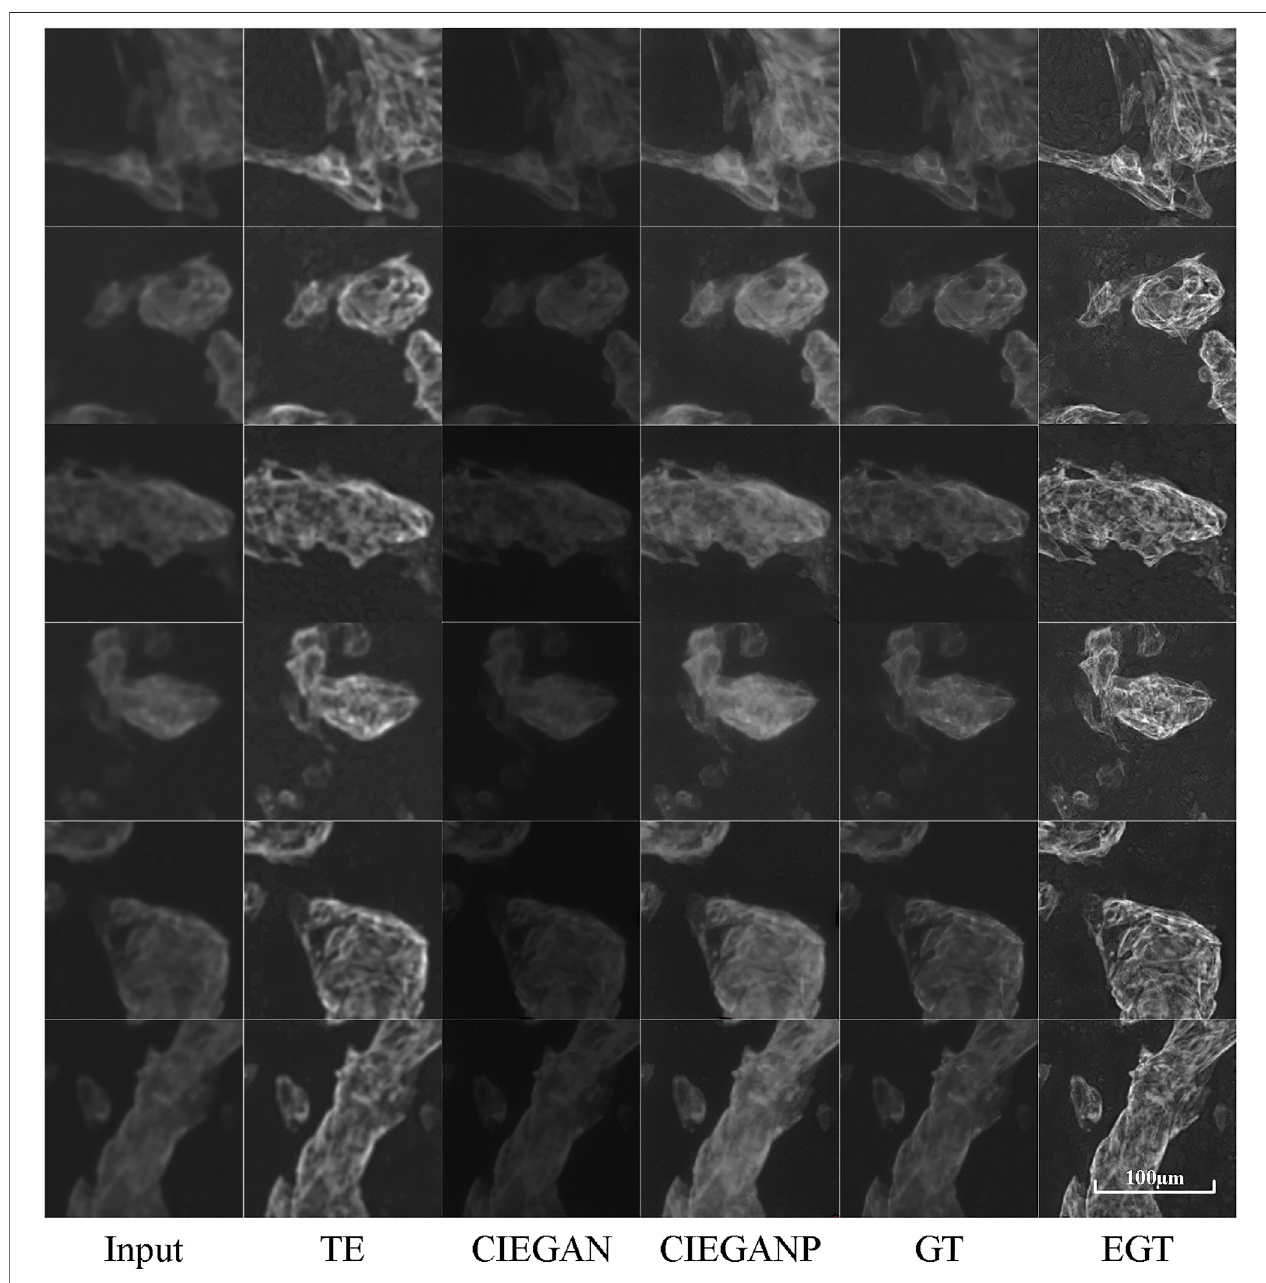
FIGURE 7 | Results of cTnT fl uorescence microscopy images of the iPSC-CM differentiation experiment. TE stands for the traditional enhancement method, CIEGAN, CIEGAN plus (CIEGANP) is our method, GT is the ground truth, and EGT is the enhanced ground